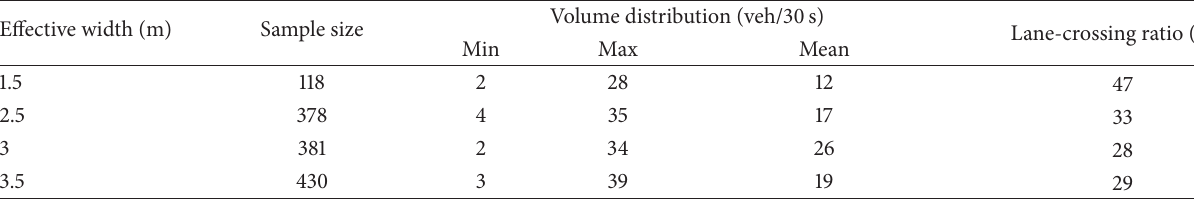
Table 3: Basic features of observed sections.